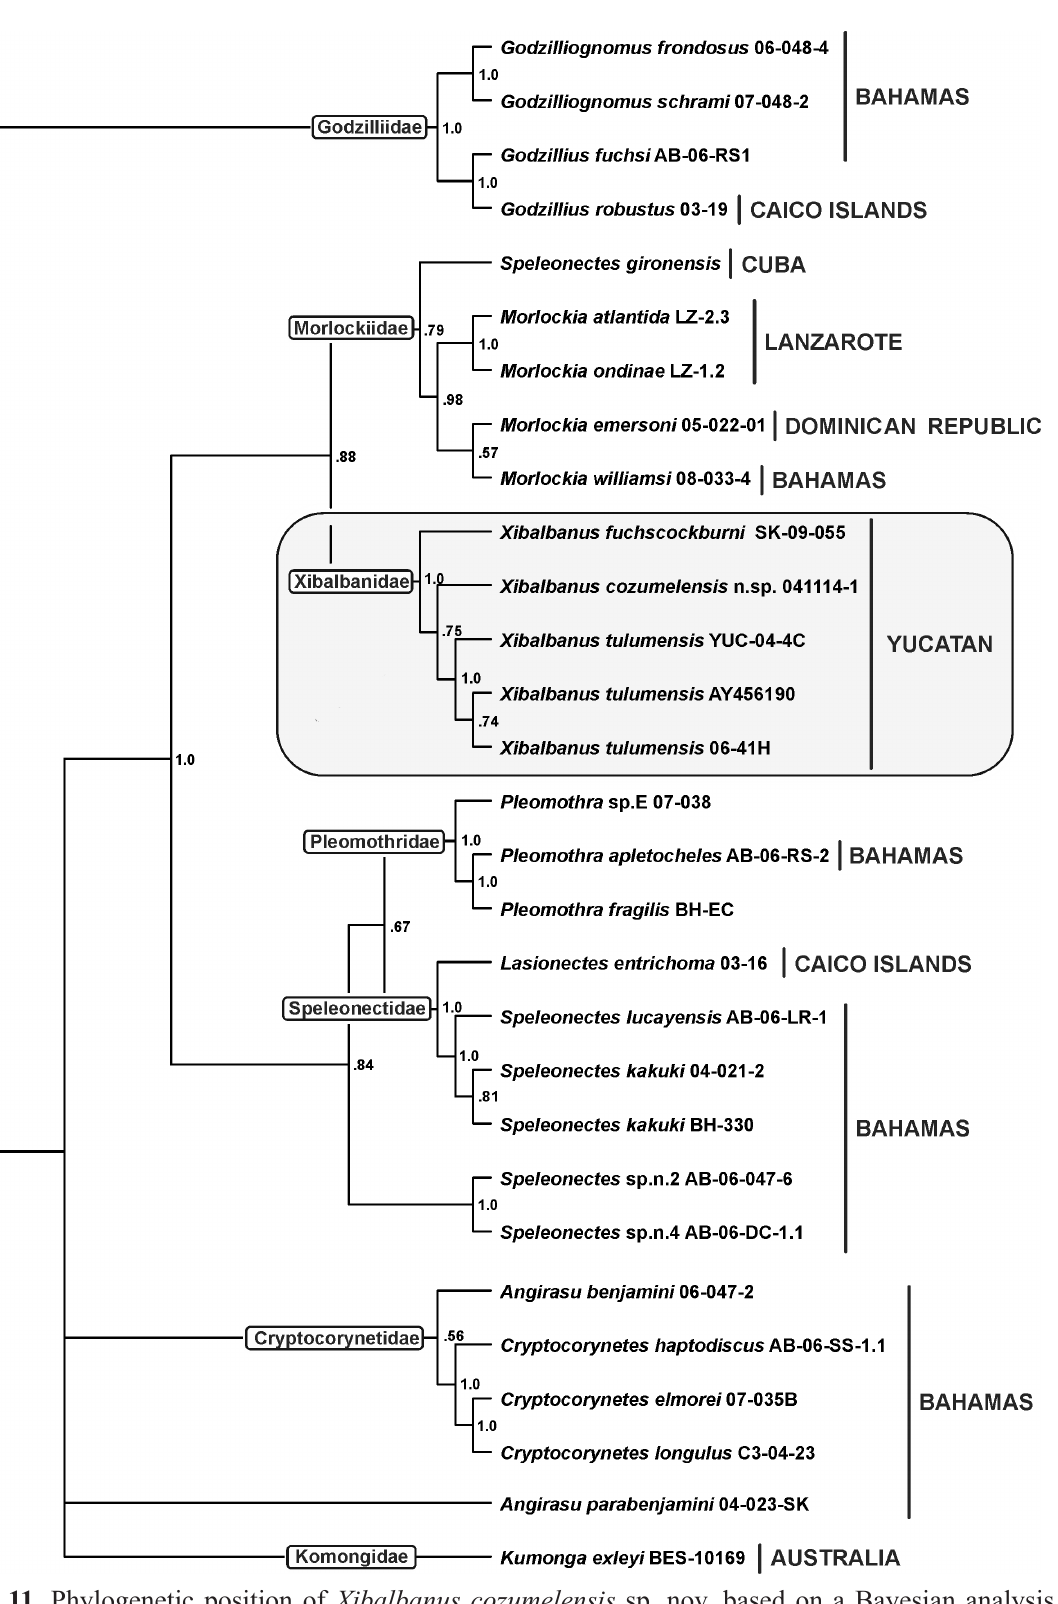
Fig. 11. Phylogenetic position of Xibalbanus cozumelensis sp. nov. based on a Bayesian analysis of partial CO1 and 16S rDNA sequences of X. cozumelensis sp. nov. and other remipedes available from